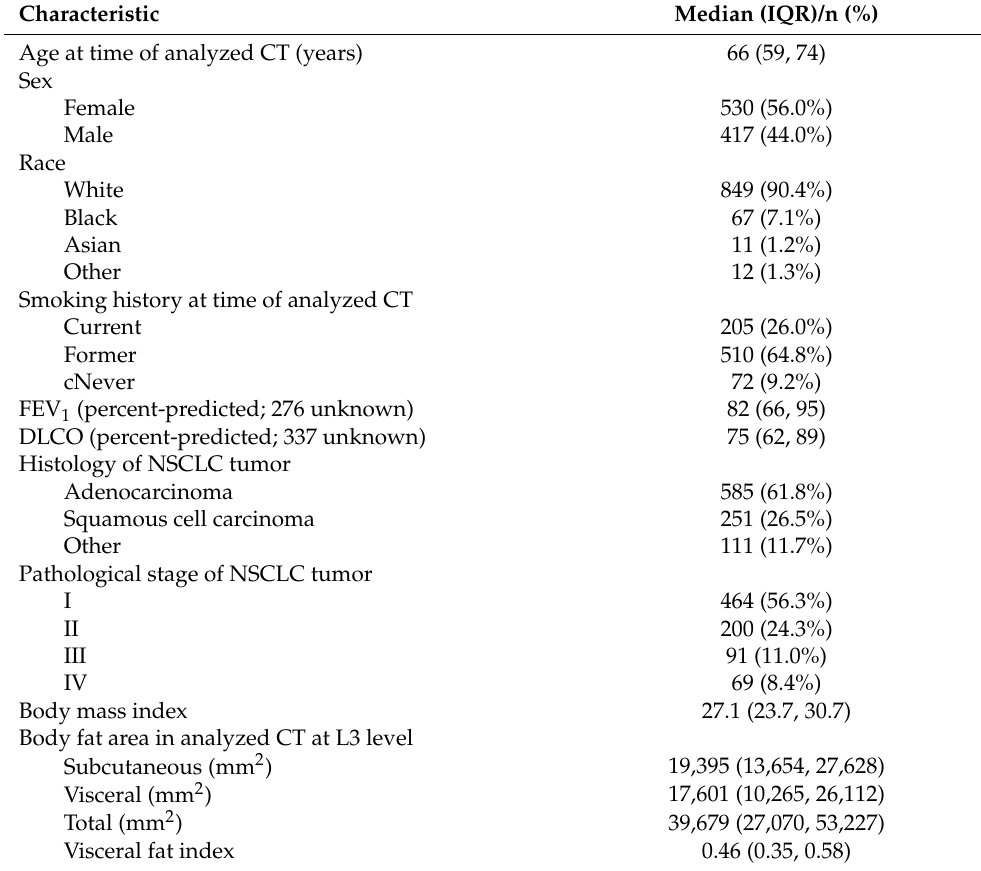
Table 1. Characteristics of the examined population at the L3 vertebral level (n = 947) 1 .